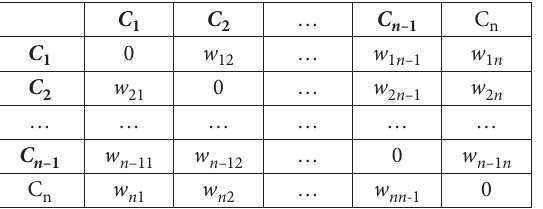
Table 2. Adjacency matrix